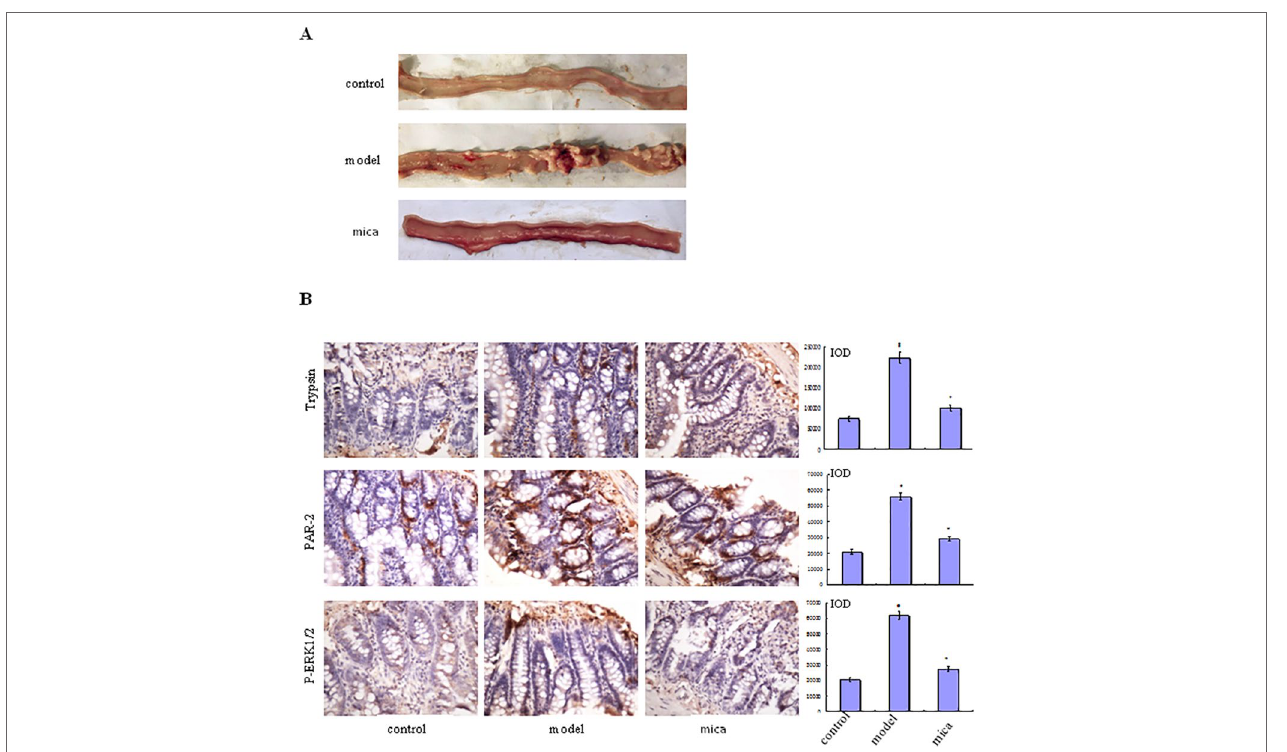
FIGURE 2 | Effects of mica on NSAID-induced small intestinal injury. (A) Macroscopic observation of small intestinal injury in control, model, and mica group (120 mg/ kg/d, 9 days). (B) The protein expression of tryptase, PAR-2, and p-ERK1/2 was measured in control, model, and mica group by IHC (×400). The bar graphs (mean ± SD) and representative images are shown. # p < 0.05 vs the control group, * p < 0.05 vs the model group. Representative views from each group are